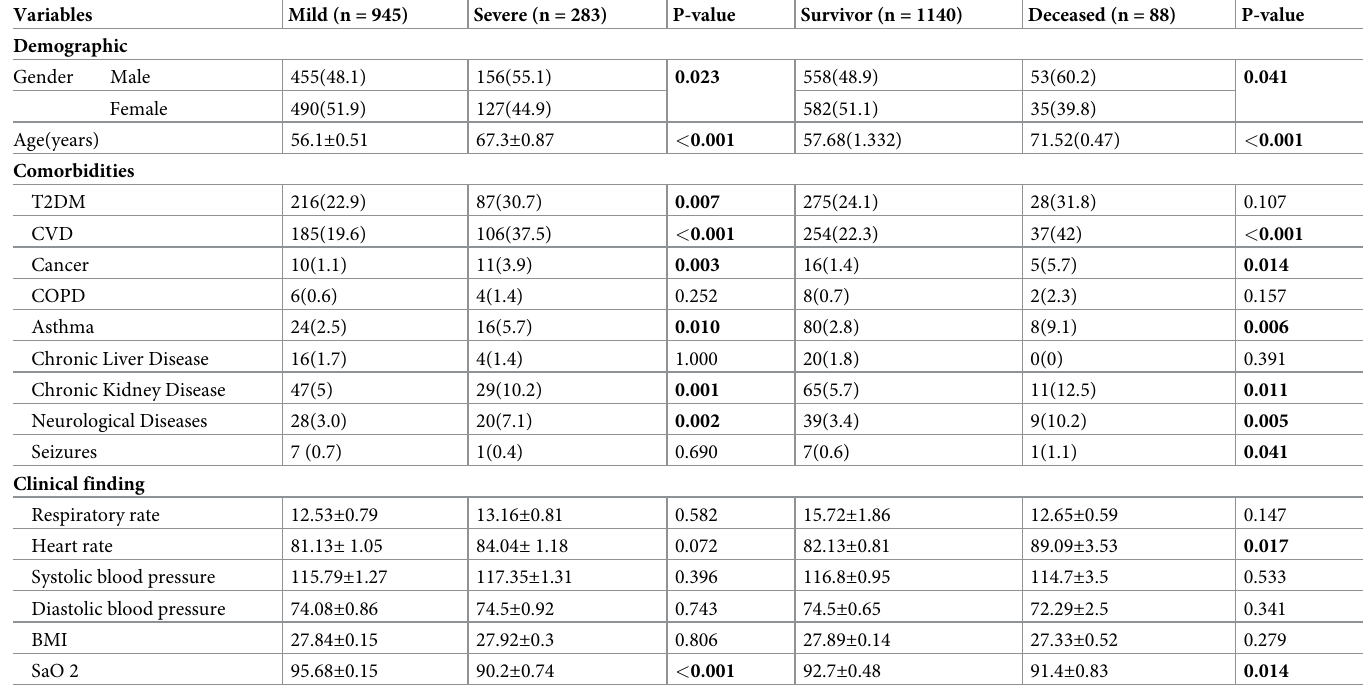
Table 1. The basic features of patients with COVID-19 in accordance with the severity and mortality.